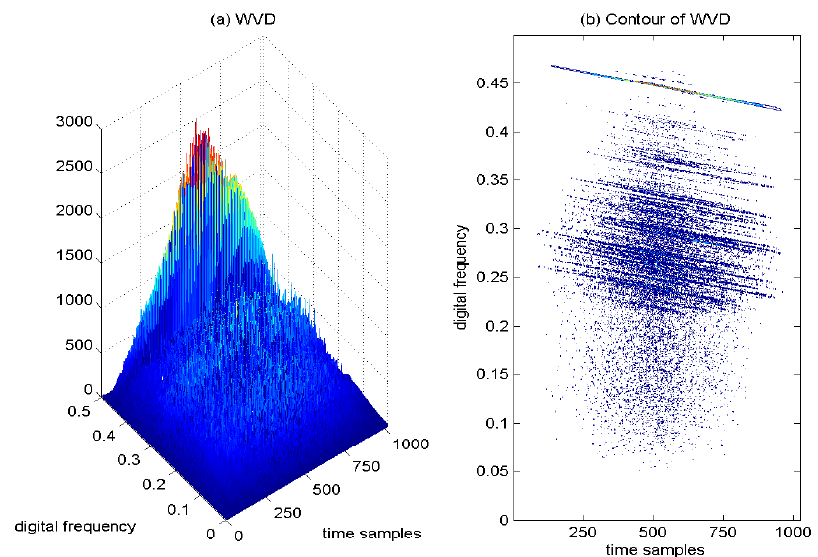
Figure 9. Wigner–Ville distribution of the GPS L1 signal with sweep interference. C/N = 46 dB-Hz, JNR = − 1 dB. 0